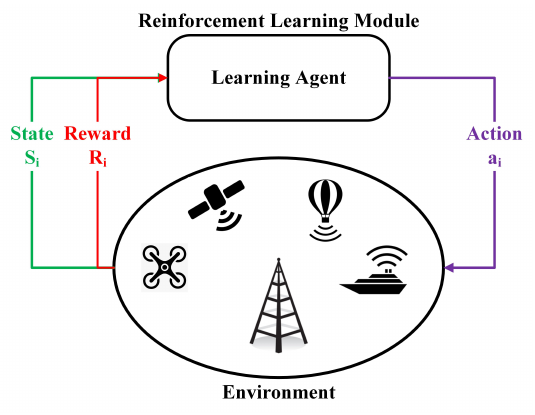
Figure 6. Potential RL-enabled 6G network orchestration